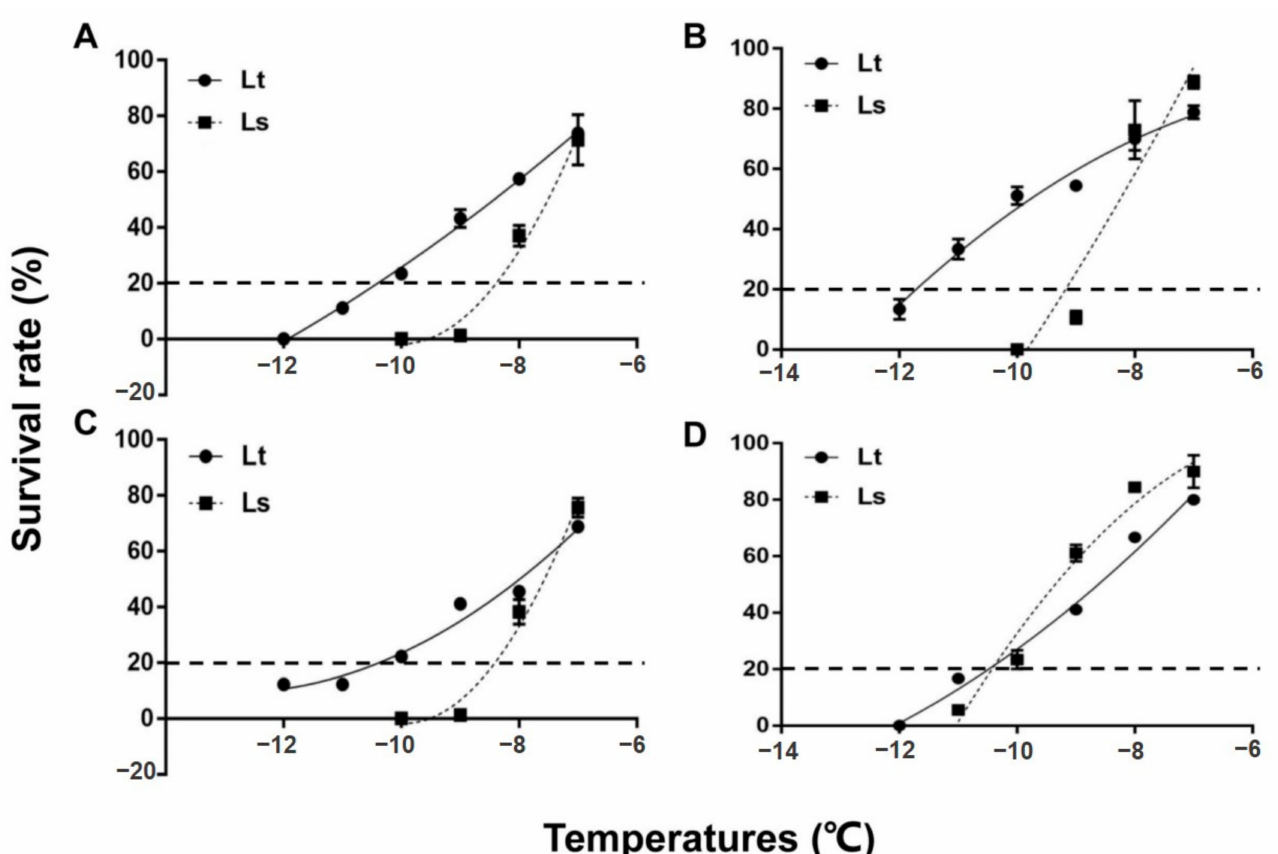
Figure 1. Survival of L. trifolii and L. sativae pupae and adults for determination of critical temperatures. Pupae and adults were exposed to subzero temperatures for 2 h. Panels: ( A ) survival of 2-d-old (CT: Lt, − 10.4 ◦ C, Ls, − 8.4 ◦ C), ( B ) 5-d-old (CT: Lt, − 11.6 ◦ C, Ls, − 8.9 ◦ C), and ( C ) 7 d-old pupae (CT: Lt, − 10.6 ◦ C, Ls, − 8.4 ◦ C). ( D ) (CT: Lt, − 10.5 ◦ C, Ls, − 10.4 ◦ C) survival of adults. Abbreviations: LT, L. trifolii ; LS, L. sativae ; and CT, critical